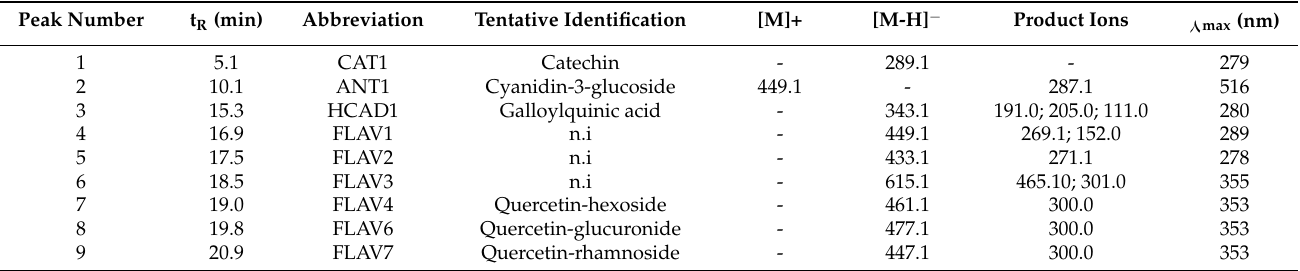
Table 2. Identification of phenolic compounds in rosehip fruits by HPLC-DAD-ESI-MS/MS.